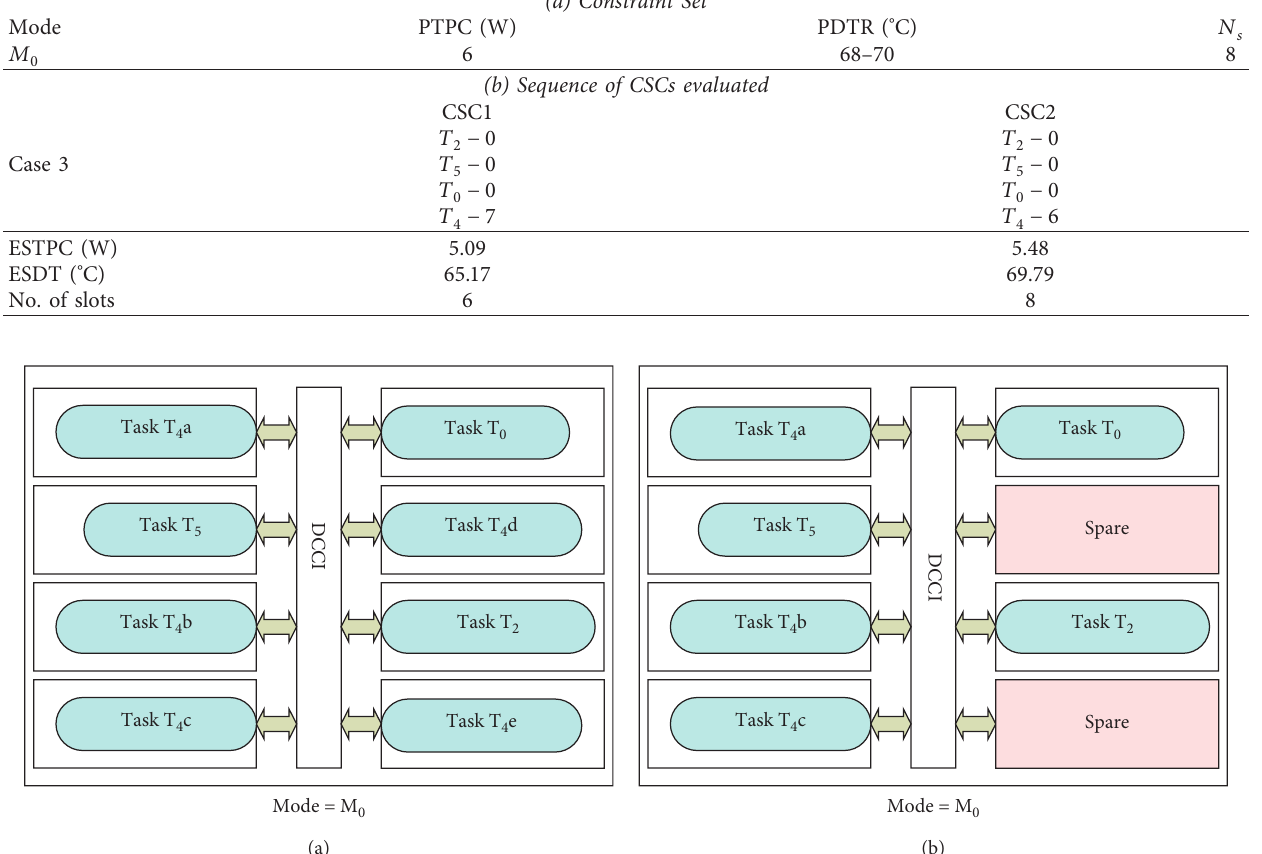
Figure 14: RTSA using Explorer for cases 3 and 4. (a) Selected system configuration for case 3. (b) Selected system configuration for case